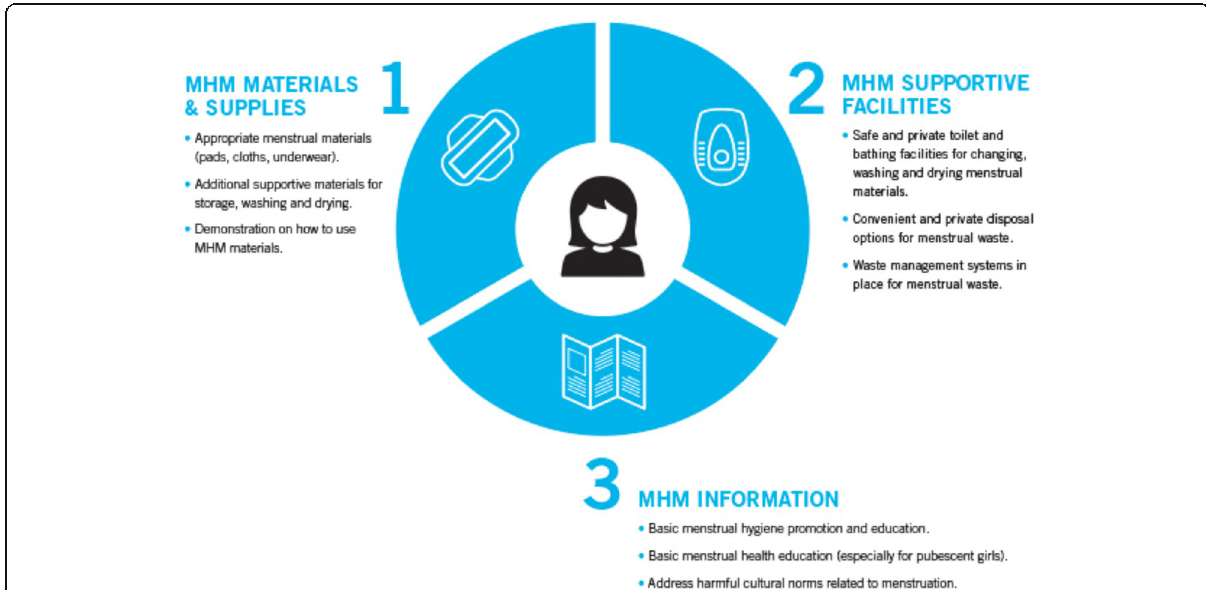
Fig. 1 Three essential components of an MHM